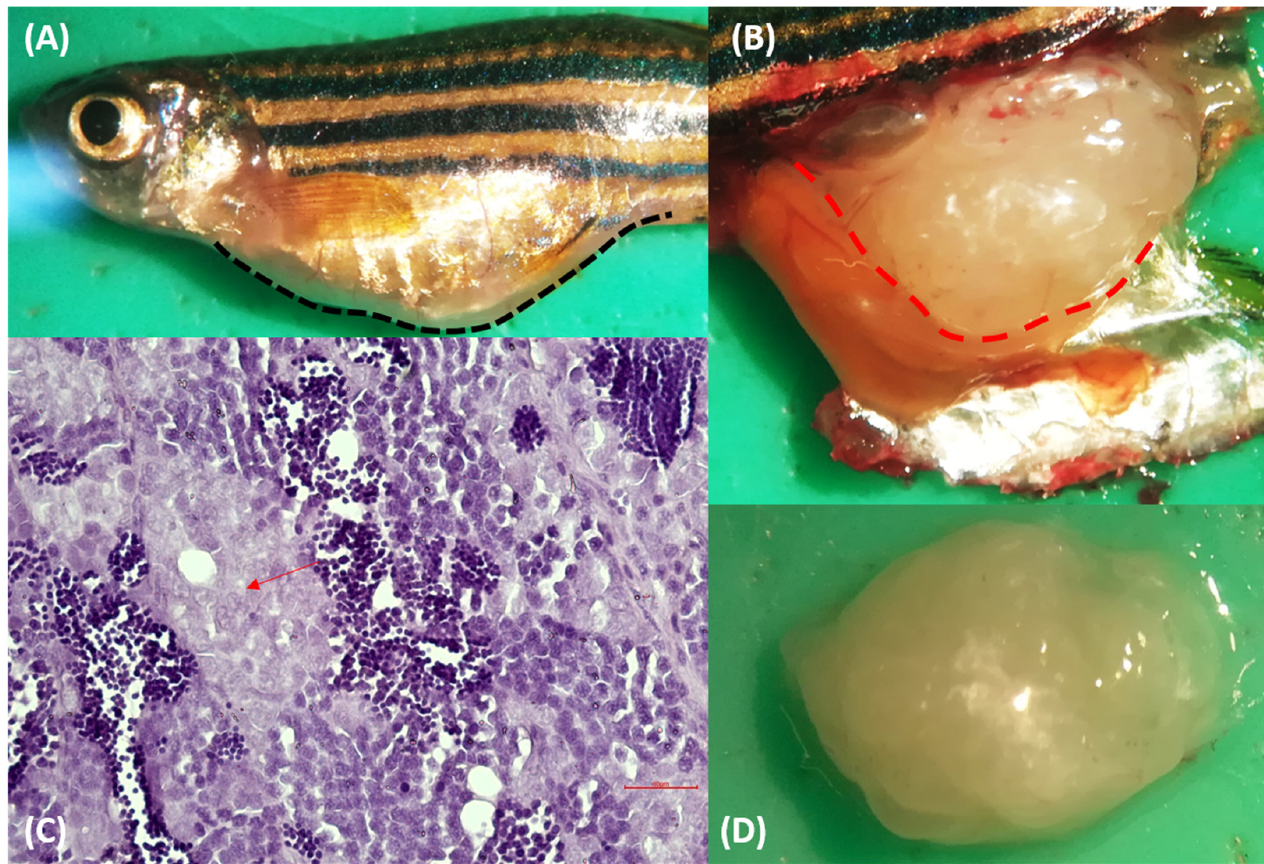
Figure 1. ( A ) Macroscopic appearance of wild-type male zebrafish of AB/TU strain Fish 1. The abdomen was considerably distended. ( B ) and ( D ) The mass filled the coelom. ( C ) Hematoxylin & eosin-stained sections from formalin-fixed, paraffin-embedded zebrafish testis’ mass: proliferation of atypical pale-staining spermatogones (red arrow), with hyperchromatic nuclei and poorly defined eosinophilic cytoplasm. Spermatocytes and spermatids were present. Bar = 10 μ m.